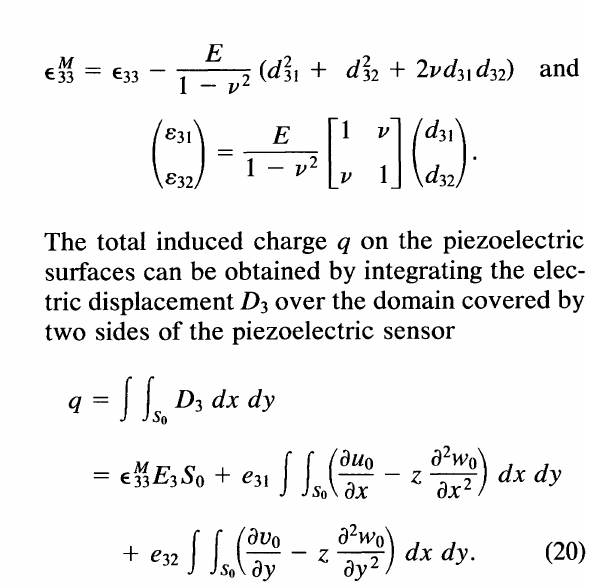
FIGURE 2 Equivalent circuit of piezoelectric